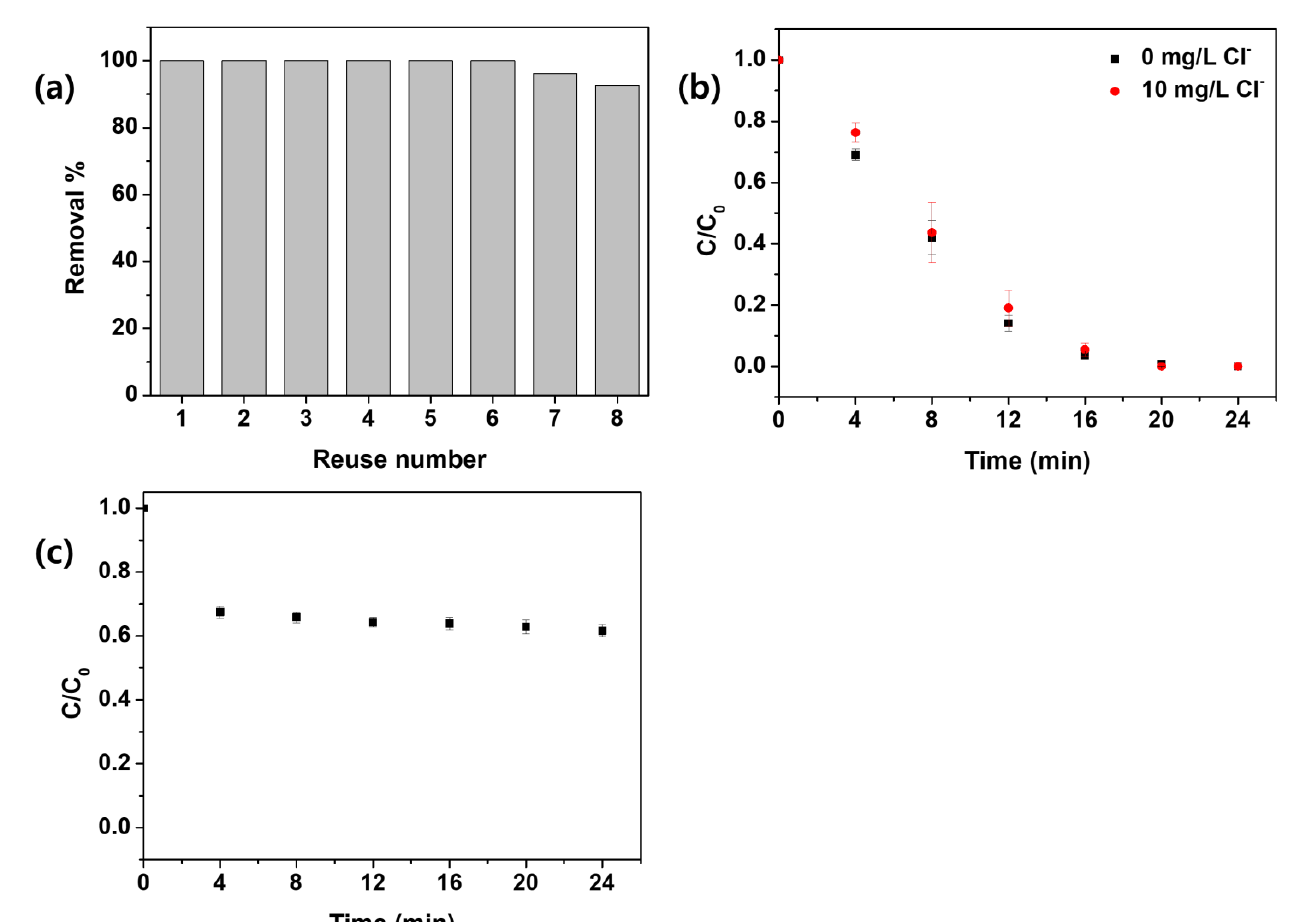
Figure 8. ( a ) Sequential oxytetracycline (OTC) degradation test ([PS] 0 = 1 mM, [OTC] 0 = 20 μ M, [HWWC] 0 = 0.2 g/L, pH = 6); ( b ) OTC degradation in the presence of Cl − ([Cl − ] 0 = 10 mg/L); ( c ) Degradation kinetics of OTC by persulfate activation using HWWC in the secondary effluent (pH = 7.2, [DOC] 0 = 4.71 mg/L, UV 254 = 0.100, SUVA = 2.12). PS: persulfate; HWWC: hand-warmer waste catalyst.